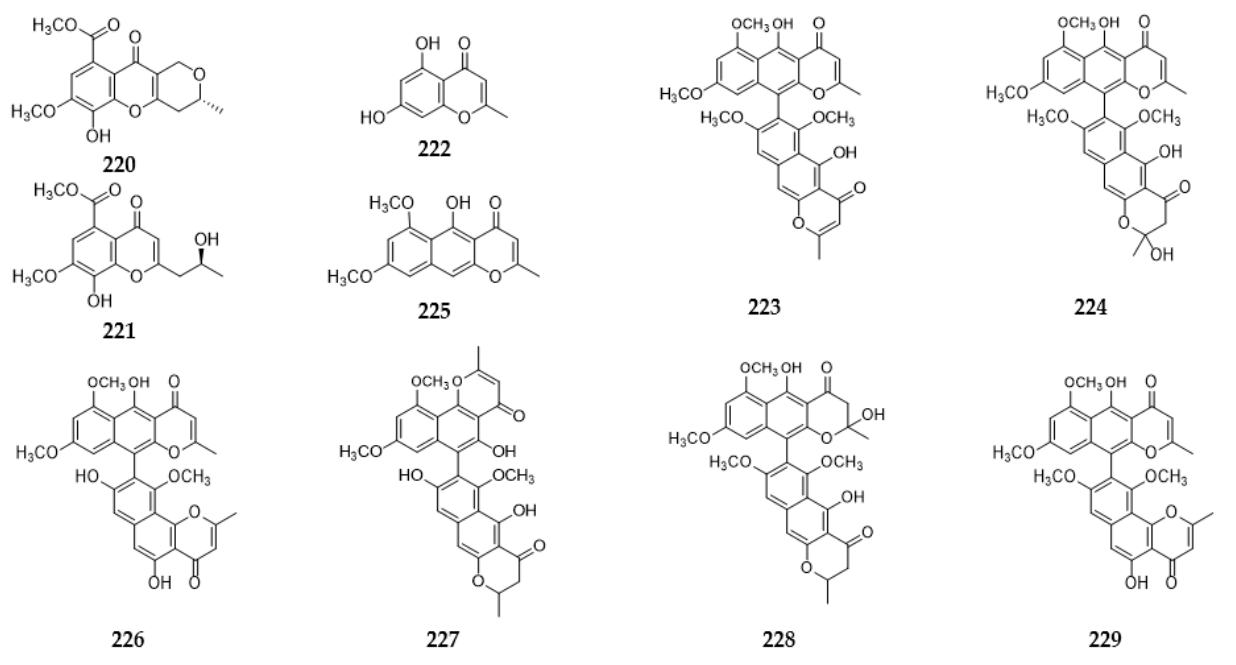
Figure 14. Aspergillus -derived benzopyranones ( 220 – 222 ) and naphthopyranones ( 223 – 229 ).